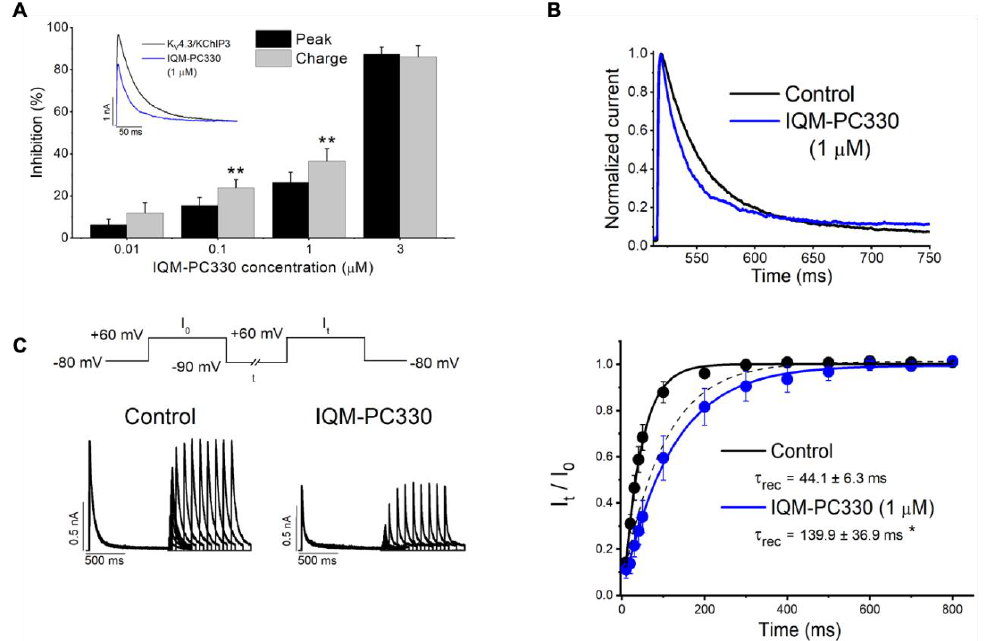
Figure 8. Electrophysiological effects of IQM-PC330 on K V 4.3 and K V 4.3/KChIP3 channels [69]. ( A ) Bar chart comparing the inhibition of K V 4.3/KChIP3 currents produced by IQM-PC330, measured at the maximum peak current and at the charge. Inset shows original current recordings. ( B ) Original normalized current records: control (black line) and with IQM-PC330 (blue line). ( C ) Left panel shows current recordings elicited by the recovery protocol shown in the top. Right panel shows the effects of IQM-PC330 on the recovery process. Dashed lines represent the recovery process of K V 4.3 current without KChIP3. Note that IQM-PC330 slows the recovery process, reverting KChIP3 effects. Data are shown as mean ± SEM. *p < 0.05; **p < 0.01.